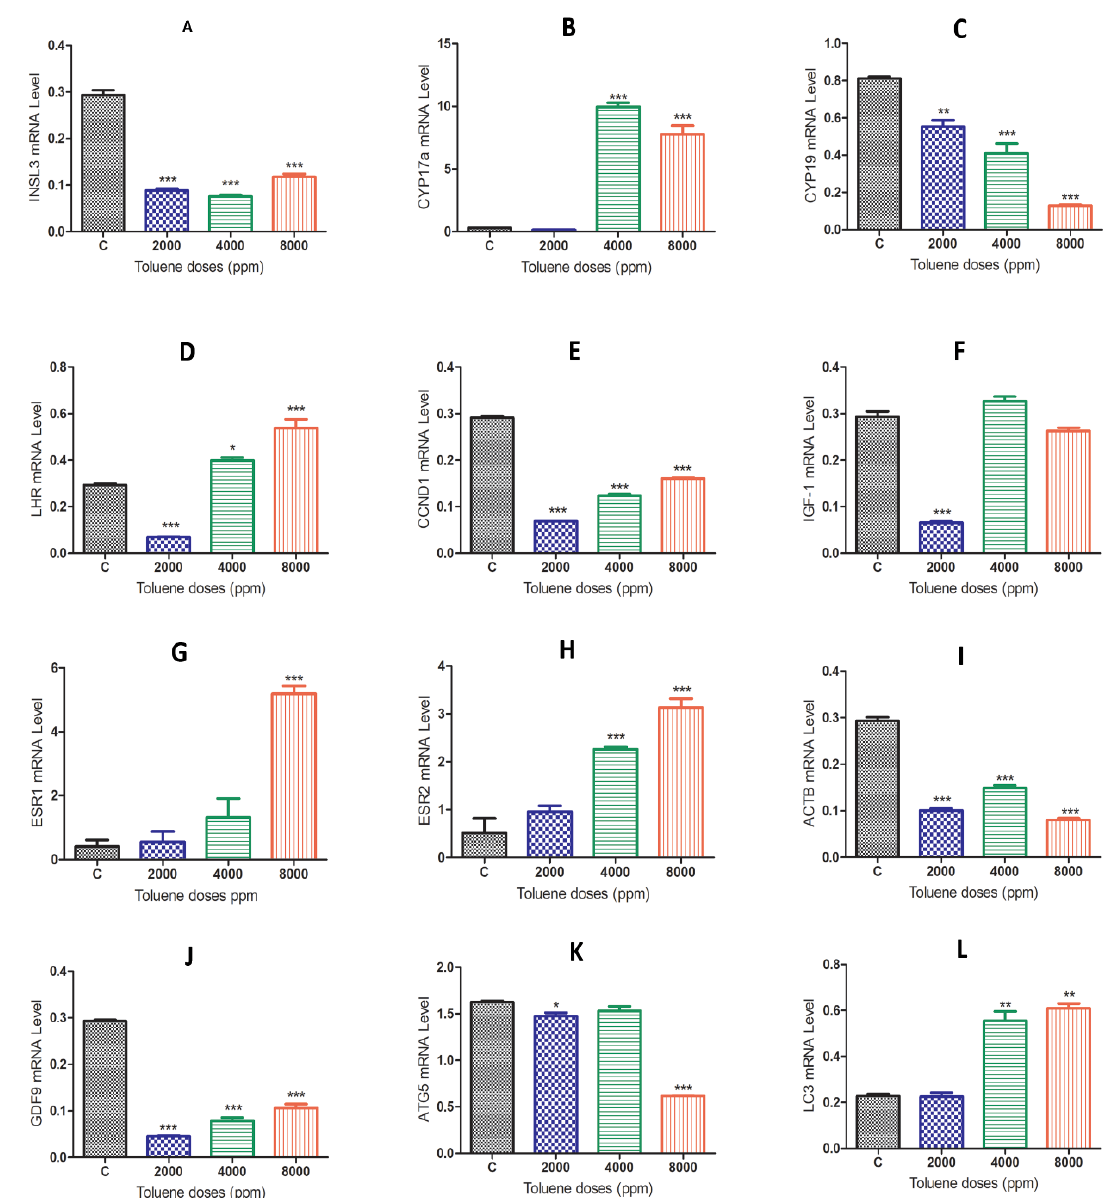
Figure 4. mRNA expression levels of different genes in the ovaries of rats in the treatment groups compared to the control group. ( A ), INSL3 ; ( B ), CYP17a ; ( C ) CYP19 ; ( D ) LHR ; ( E ) CCND1 ; ( F ) IGF-1 ; ( G ) ESR1 ; ( H ) ESR2 ; ( I ) ACTB ; ( J ) GDF-9 ; ( K ) ATG5 ; ( L ) LC-3 ; Values are means ± S.E.M. *, p < 0.05; **, p < 0.01; ***, p < 0.001.